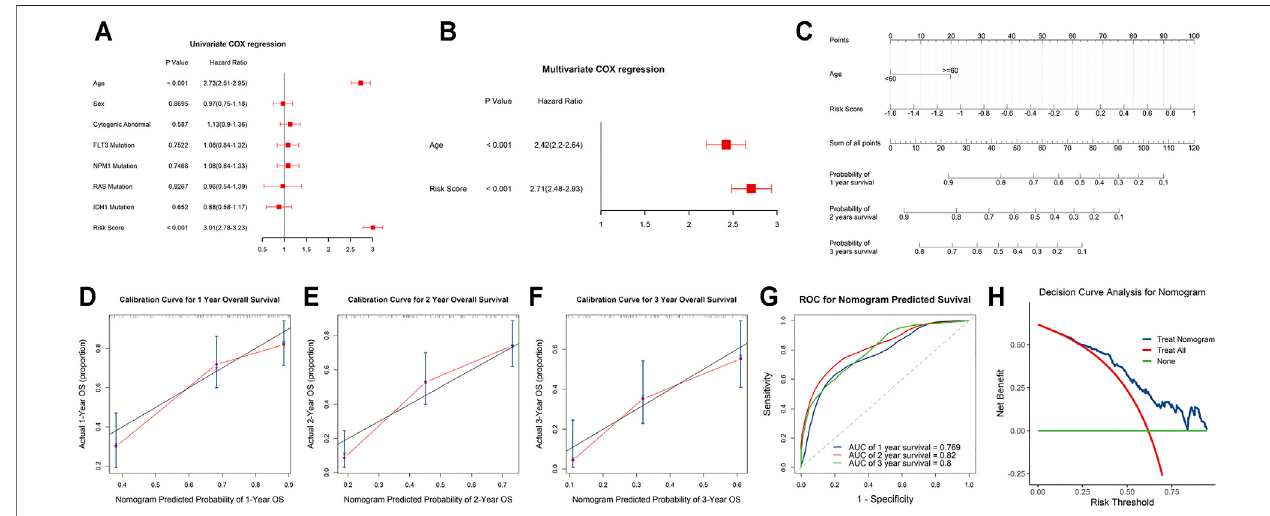
FIGURE 6 | Independent prognostic and clinicopathological correlation analyses (A,B) Cox regression analysis of the clinical variables and risk scores. (C) Construction of a nomogram for 1-, 2-, and 3-year survival prediction along with risk score and age. (D – F) Calibration curves evaluated the consistency of nomogram. (G) Time-dependent ROC curves of the nomogram and their AUC values at 1-, 2-, and 3-year. (H) The decision curve analysis of the nomogram.